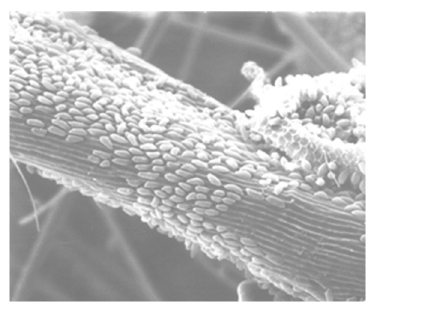
Table 2. Major differences among the three predominant ruminal cellulolytic bacteria, revealed from studies in pure